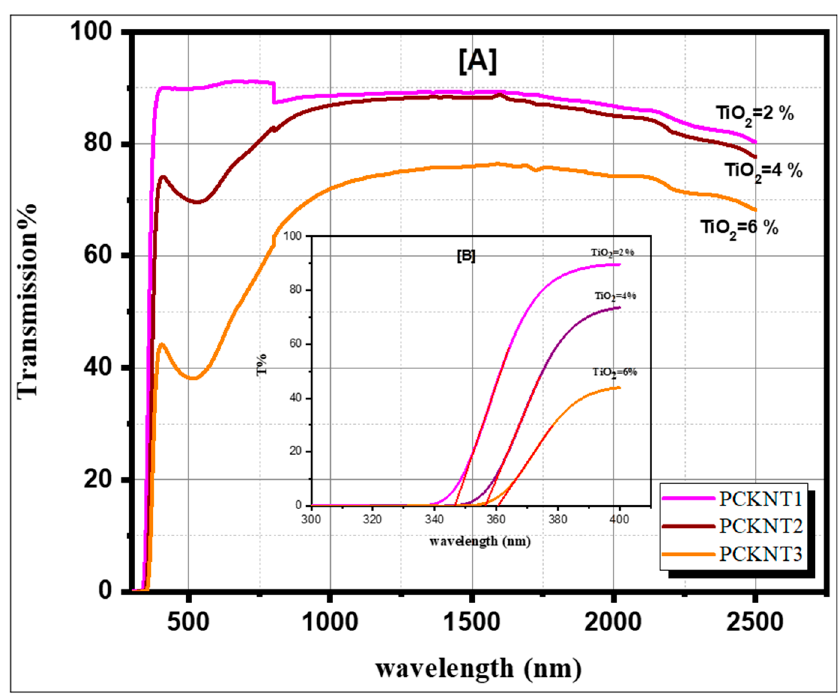
Figure 2. UV-Vis-NIR transmission spectra of the TiO (cid:2870) -doped phosphate–titanite glasses.